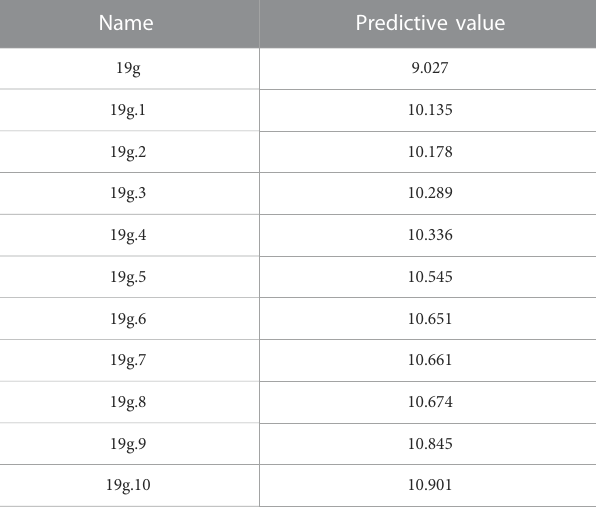
TABLE 6 The compounds of newly designed and their predicted values.